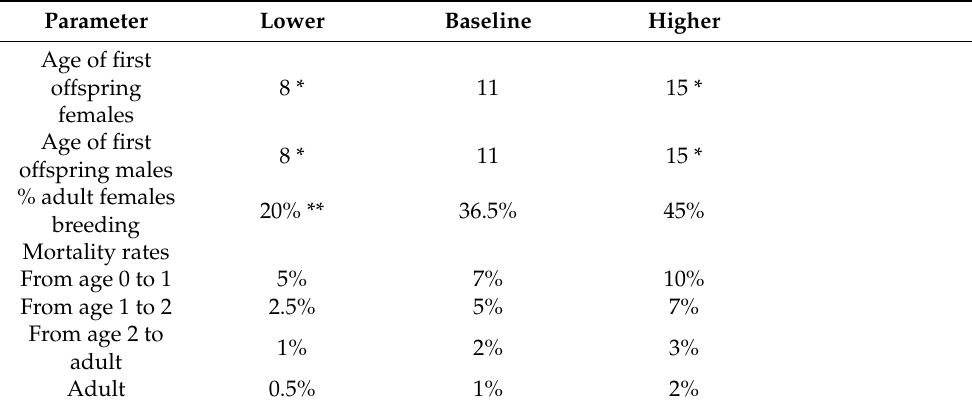
Table 2. Lower and higher values used for sensitivity